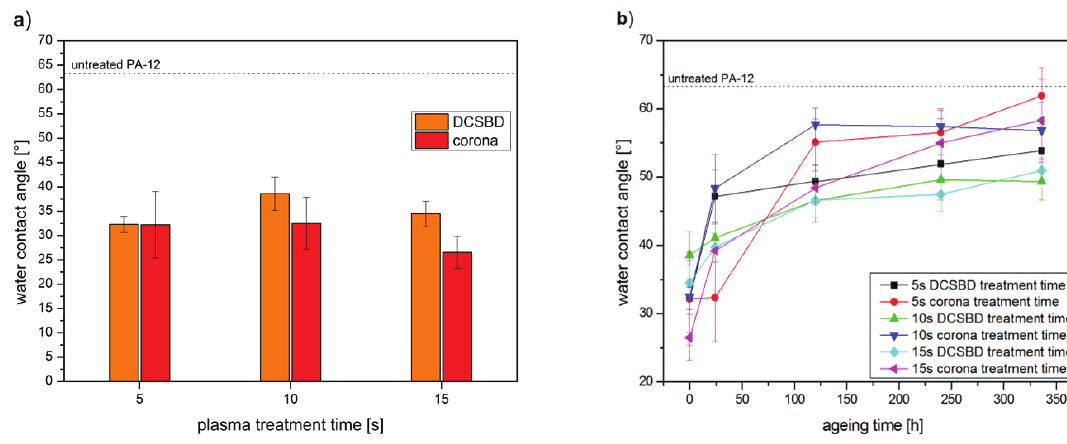
Figure 2: a) The effect of plasma treatment time on PA-12 wettablility, (DCSBD and industrial corona), b) Ageing effect of plasma